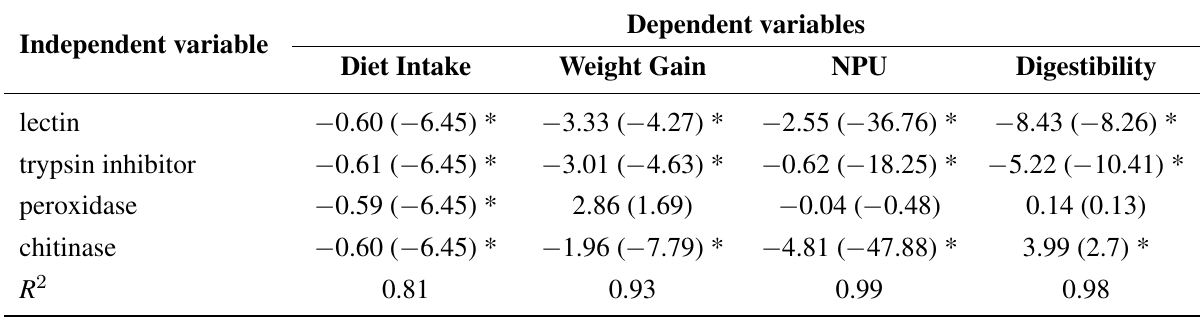
Table 6. Regression results: estimated coefficients, T-ratios and R 2